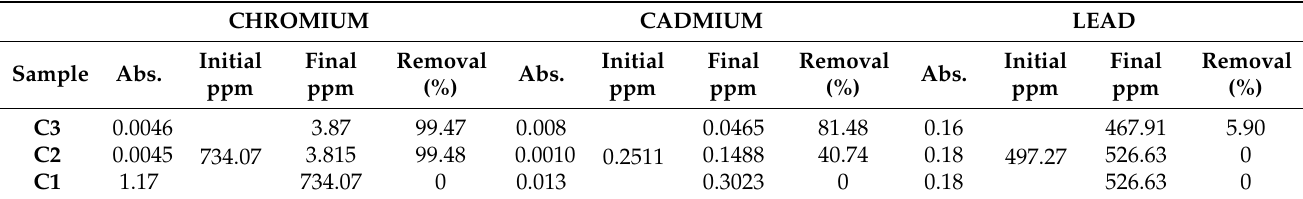
Table 1. Atomic absorption results in agricultural soil samples for chromium, cadmium, and lead; influence in function of FeO NP. CHROMIUM CADMIUM LEAD